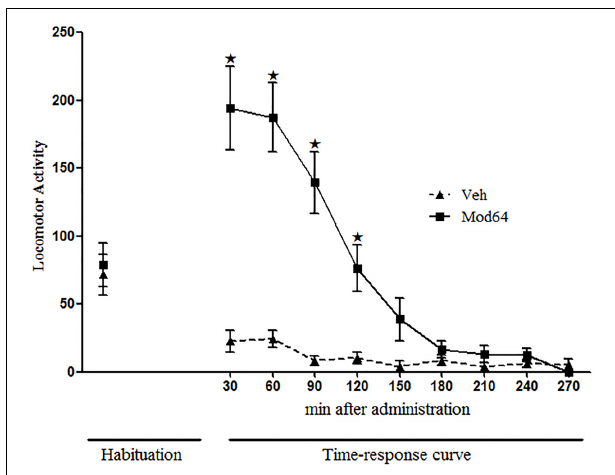
FIGURE 2 | Locomotor activity in the open field during the 3rd day of habituation and throughout 270 min after acute administration of vehicle (Veh) or 64 mg/kg modafinil (Mod64). During the open-field test, locomotor activity was measured for 10 min, every 30 min, for a period of 240 min. Data are reported as mean ± SEM ( n = 10). (cid:70) P < 0.05 compared with Veh group at the respective time interval.